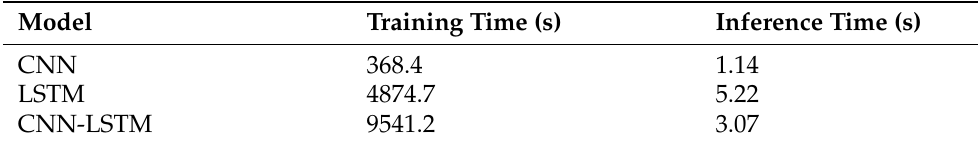
Table 8. Training and inference times of the